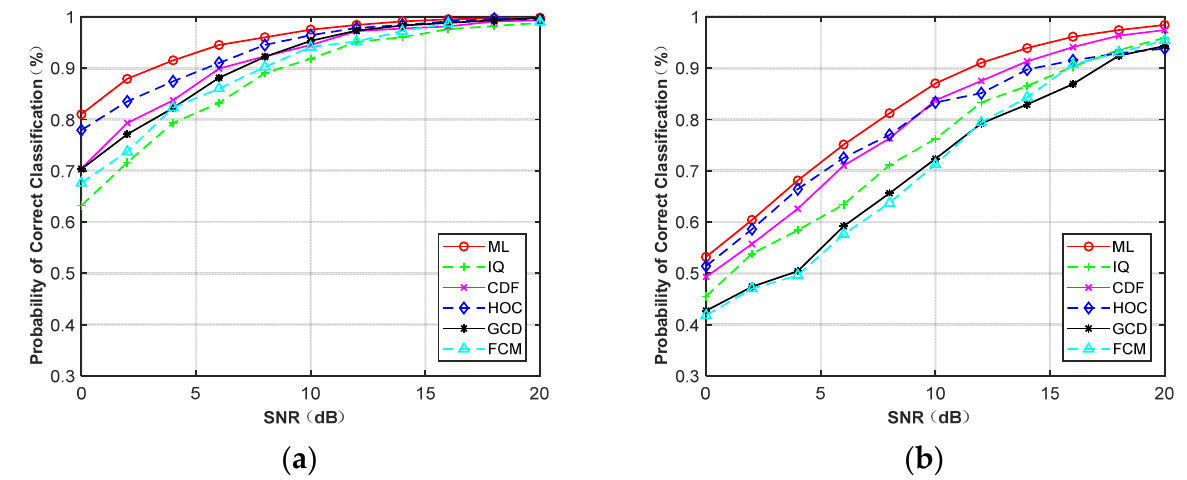
Figure 13. Probability of correct classification under flat-fading channel (N = 512). ( a ) MPSK. ( b ) MQAM.